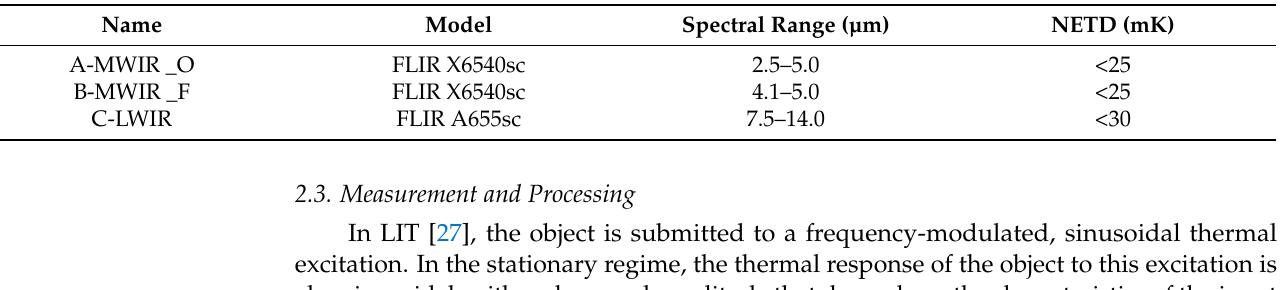
Figure 2. ( a ) Schematic of the measurement setup. Either a short pulse (PPT) or a modulated sinusoidal wave (LIT) is sent to the light controller. The distance between the painting and the camera depends on the size of the painting. ( b ) RGB image showing the measurement setup during experiments, on the Saint-George icon. Table 1. Summary of the used camera setups and their most important